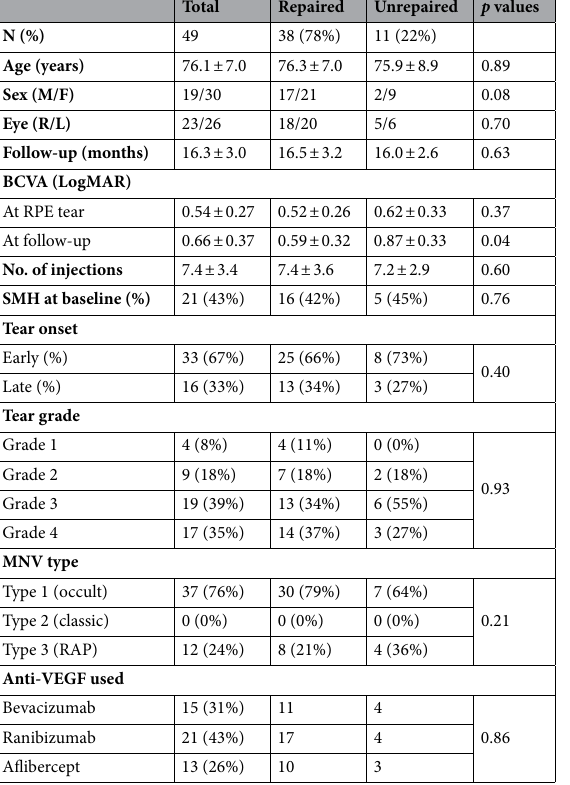
Table 1. Demographic and clinical characteristics of the studied cohort. Legend: N, number; BCVA, best- corrected visual acuity; SMH, sub-macular hemorrhage; MNV, macular neovascularization; RAP, retinal angiomatous proliferation; VEGF, vascular endothelial growth